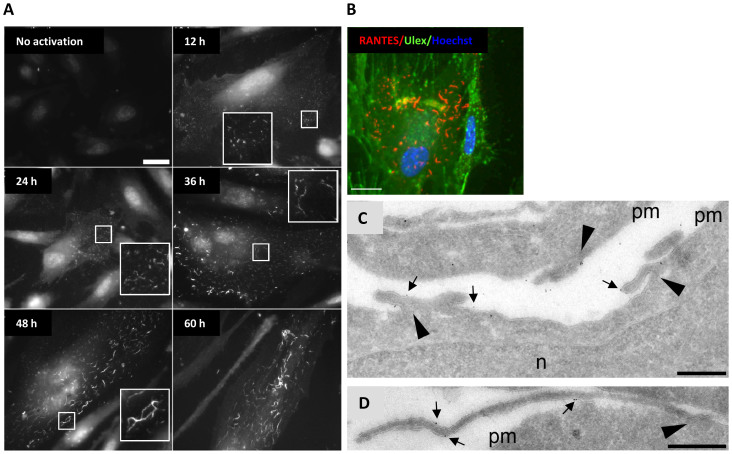
RANTES organizes in filaments on the cell surface and the filament length
increases with incubation time in the presence of TNFα and IFNγ.(A) HUVECs were cultured in growth medium with 10 ng/ml TNFα and
1 ng/ml IFNγ for different time points (indicated in each image)
before fixation and immunostaining with clone ID2/A12. Inserts show
structure details at 3 × magnification. Scale bar, 10 μm.
The images were acquired by widefield microscopy. (B) HUVECs were stimulated
with 10 ng/ml TNFα and 1 ng/ml IFNγ for 30 h
and then immunostained with a rabbit anti-RANTES antibody on ice to label
only extracellular, surface associated RANTES. Ulex, a lectin, was utilized
to label the surface of all HUVECs. Scale bar, 10 μm. Images were
acquired by sequential scanning confocal microscopy. (C, D) HUVECs were
stimulated with 10 ng/ml TNFα and 1 ng/ml IFNγ for
36 h and frozen for cryosectioning before immunogold detection of
RANTES with a goat anti-RANTES antibody. The images show sections of the
outer part of HUVECs, with membrane projections originating from the cell
surface (arrowheads). Arrows indicate immunogold labelled RANTES. pm, plasma
membrane; n, nucleus. Scale bars, 500 nm.